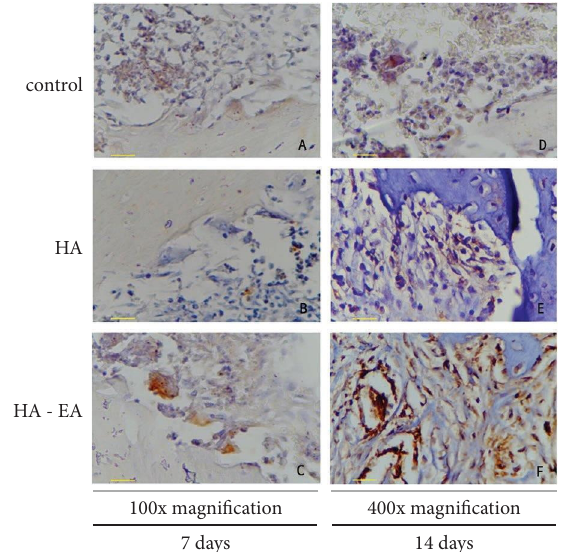
Figure 5: OPN expression in bone tissue 7 days after application (a, b, and c) and 14 days after application (d, e, and f). Te OPN expression was expressed in osteoblast as brown colour in